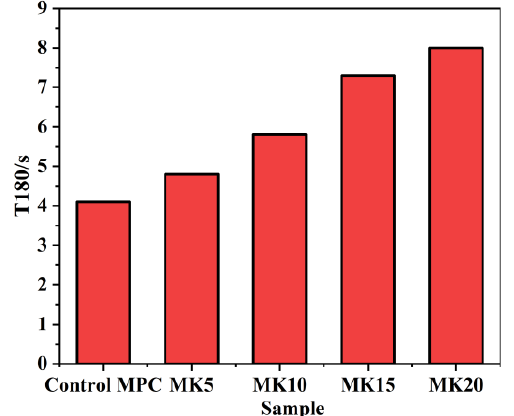
Figure 8. The effect of MK content on MPC T180 value.